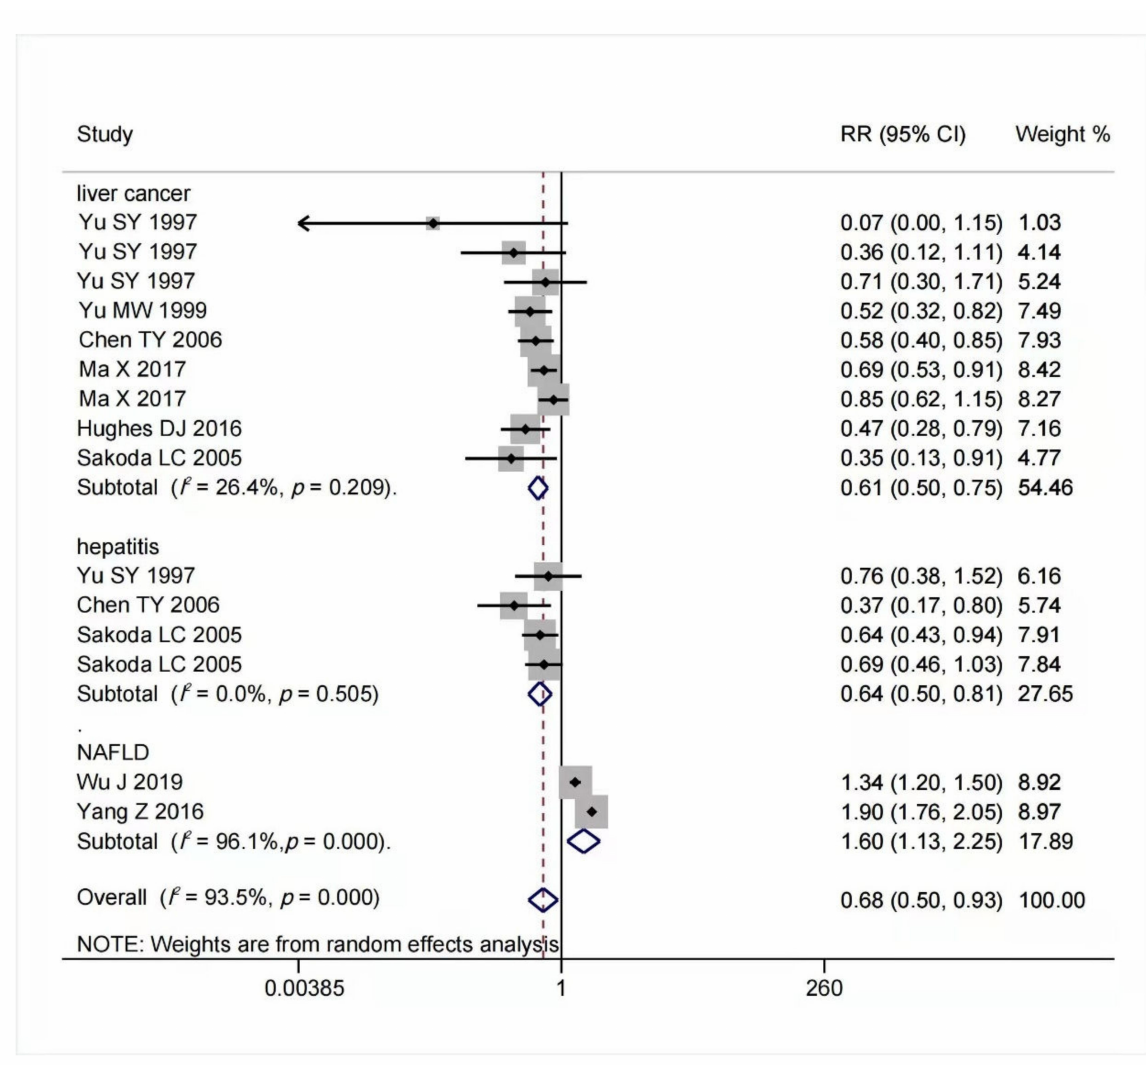
Figure 3. Pooled RRs of selenium intake and chronic liver diseases. Stratified by disease progres- sion